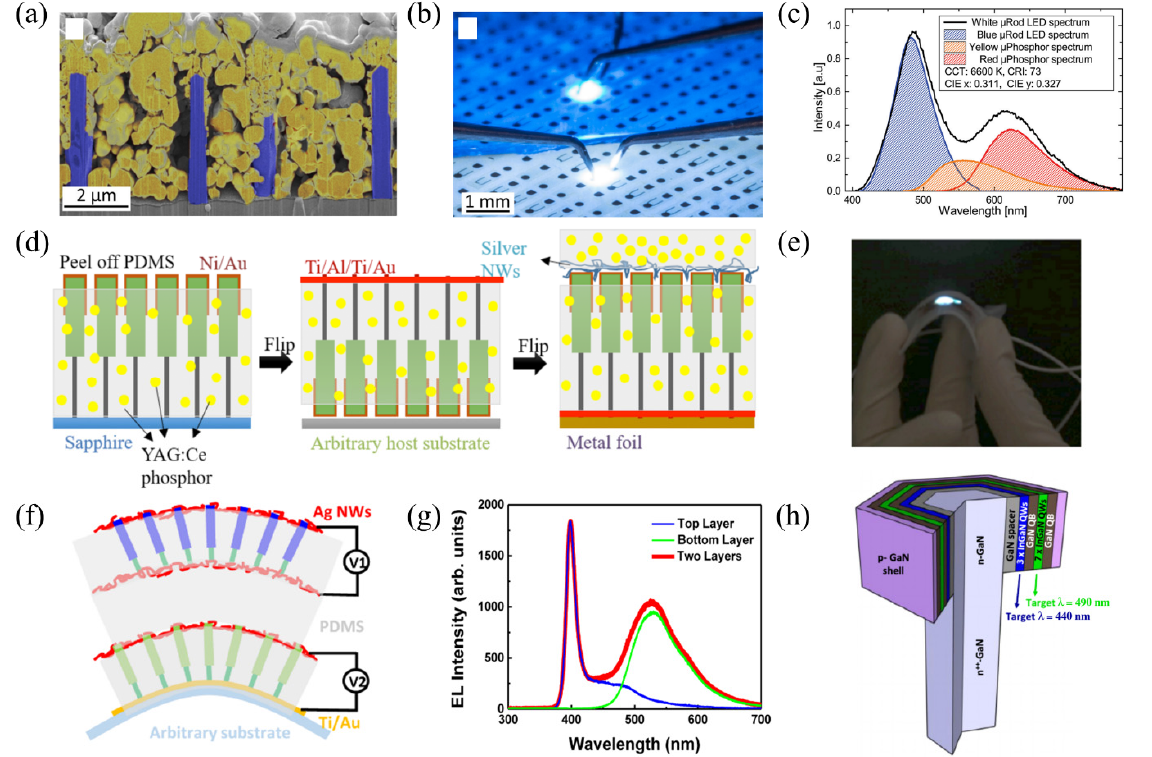
Figure 7. ( a ) Colored SEM image of a microrod LED (blue) where a microcrystalline phosphor (yellow) was deposited between the microrods. Reprinted with permission from Ref. [3]. Copyright 2016 WILEY-VCH Verlag GmbH & Co. KGaA, Weinheim. ( b ) Image of a microrod device with blue (top) and phosphor-converted white (bottom) emission. Reprinted with permission from Ref. [3].